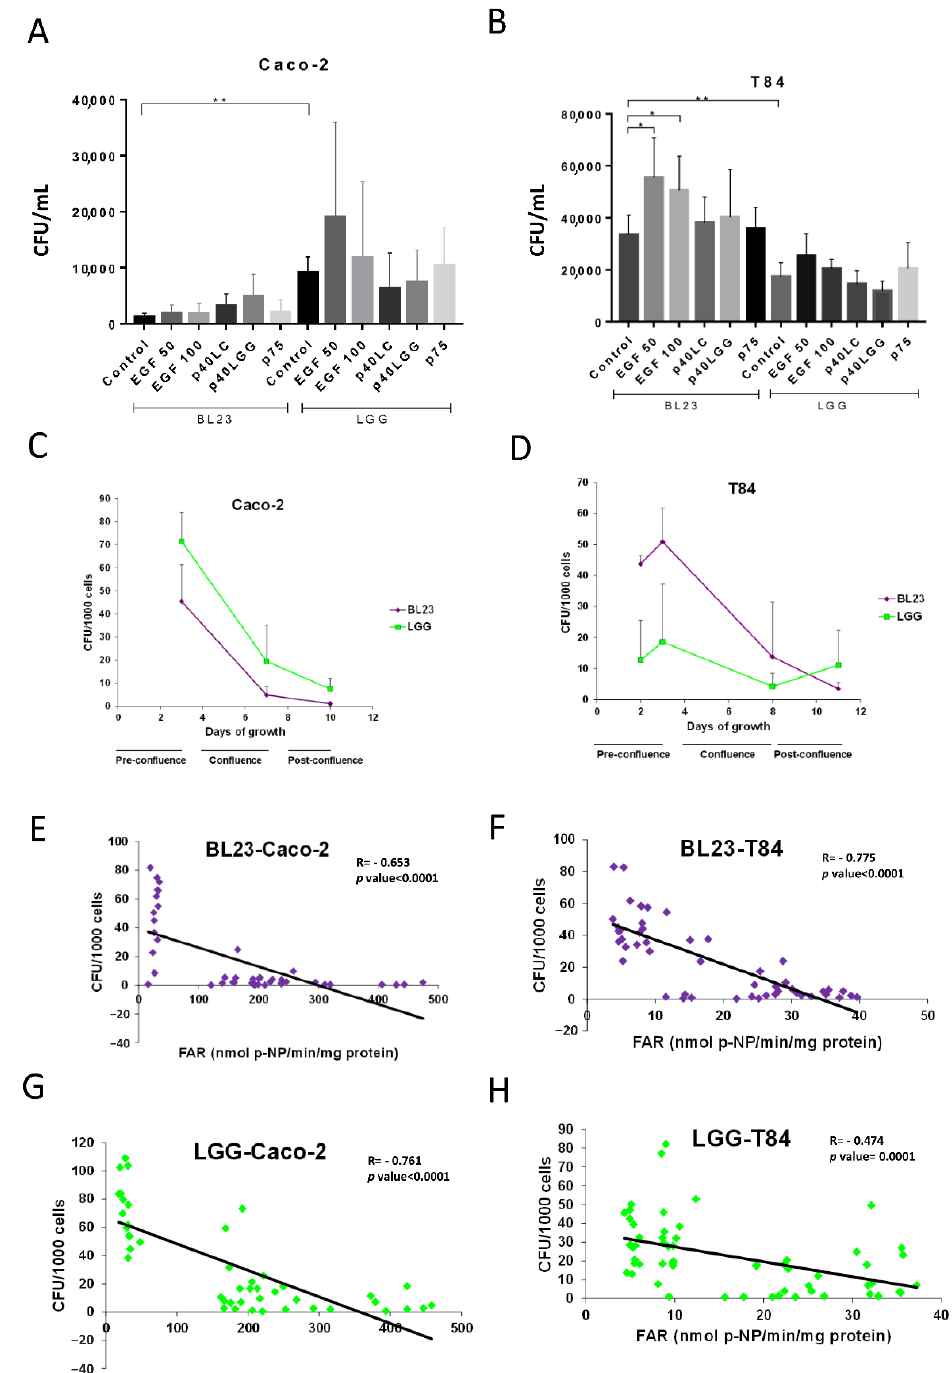
Figure 3. Relationship between growth stage and bacterial internalization. Graphs show gentamicin internalization assays after treatment with 50 and 100 ng/mL EGF on BL23 and LGG uptake by ( A ) Caco-2 and ( B ) T84 cells. The experiments were carried out with five replicates in triplicate and the differences between groups compared with the Bonferroni test ( A,B ) * p < 0.01; ** p < 0.001. Internalization was also determined at different confluence stages (pre-confluence, confluence, post- confluence) in the IEC of ( C ) Caco-2 and ( D ) T84. Internalization vs. differentiation of IEC—given as relative intestinal alkaline phosphatase activity (FAR)—was studied with BL23 ( E ) by Caco-2 and ( F ) by T84, and with LGG ( G ) by Caco-2 and ( H ) by T84. Pearson correlation analysis ( C – F ). Where R: Pearson’s correlation coefficient, p -value ≤ 0.0001.